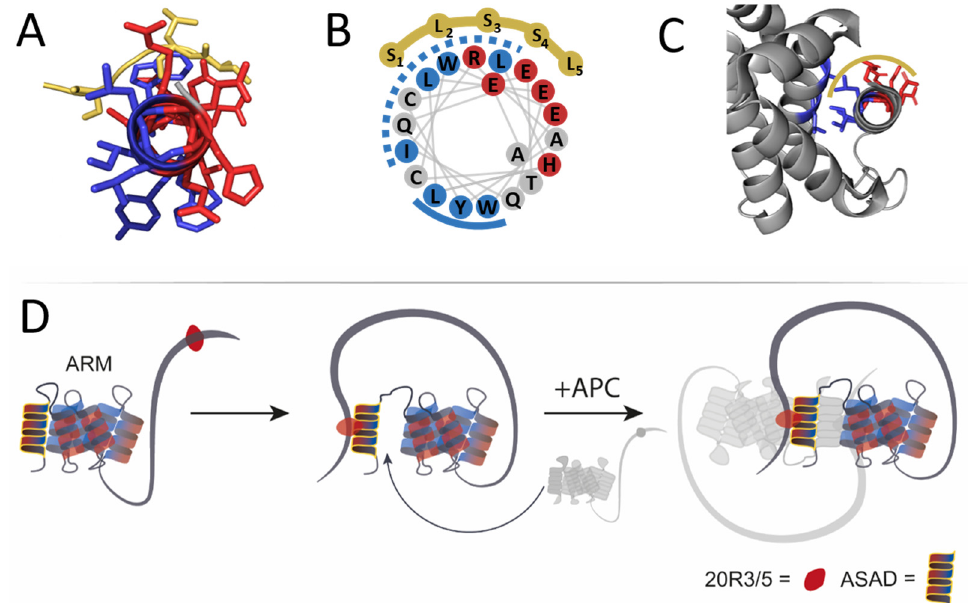
Figure 6. A scheme of the proposed self-association process of APC mediated by residues ~350–2000 spanning the ARM and 20R domains. ( A ) A prediction of the ASAD (red and blue helix) binds the SLSSL repeat (dark yellow) via both hydrophobic and charged patches. ( B ) A wheel projection of the ASAD, showing its two hydrophobic patches, 1 and 2 (dashed and solid blue lines, respectively). SLSSL repeat binds the ASAD via its first hydrophobic patch and the charged patch, possibly promoting separation of the ASAD from the ARM domain. ( C ) Crystal structure [20] of the ARM repeat (gray) shows that the ASAD (red and blue helix) binds the following helical repeat by its second hydrophobic patch, which does not bind SLSSL. ( D ) 20R3/5 (red circles represent either 20R3, 20R5, or both) binds the ASAD (yellow). Upon binding SLSSL, the first hydrophobic patch (dashed line, Figure 6B) dissociates from the ARM repeat. The disassociation of the second hydrophobic patch of the ASAD (solid line, Figure 6B) is required for APC oligomerization by binding the ASAD from another APC molecule (light gray).